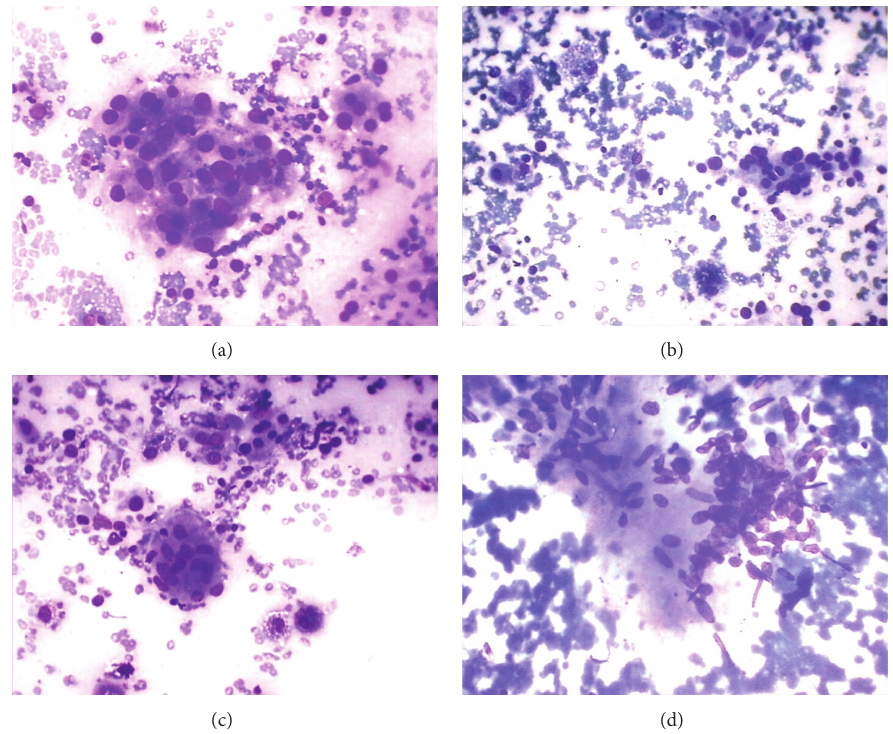
Figure 2: (a) Cluster of follicular epithelial cells showing Hurthle cells changes (Giemsa × 400). (b) Cluster of follicular epithelial cells with pigment laden macrophages (Giemsa × 400). (c) Giant cells with few follicular epithelial cells (Giemsa × 400). (d) Granuloma in lymphocytic thyroiditis (Giemsa ×